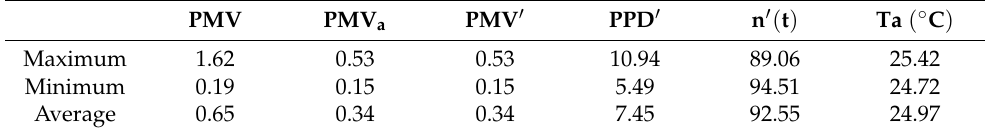
Table 8. Summary of the PMV, PMV a , PMV (cid:48) , PPD (cid:48) , n (cid:48) ( t ) , and adaptive